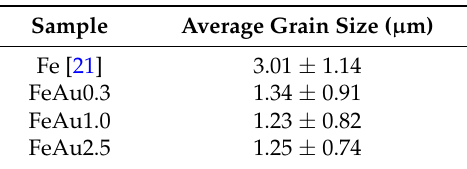
Figure 3. STEM images and EDX Fe-K- α and Au-L- α elemental mappings of Fe-Au sample cross-section, as deposited ( a ) and annealed at 800 °C for two hours ( b – g ). In the images Au precipitates appear bright due to the material contrast. ( a ) FeAu2.5 sample as deposited with intact multilayer structure; ( b ) FeAu2.5 sample annealed and ( c ) Fe-Au STEM/EDX mapping of Au precipitates in a grain and along a grain boundary; ( d ) FeAu1.0 sample annealed; the bright Au precipitates are barely visible along the grain boundaries but still resolvable in the EDX mapping ( e ). FeAu0.3 sample annealed ( f ), bright areas along the grain boundaries cannot be identified by EDX mapping ( g ). Table 2. Average grain size of the different samples annealed at 800 °C, 2 h. The values are determined from SEM surface images.